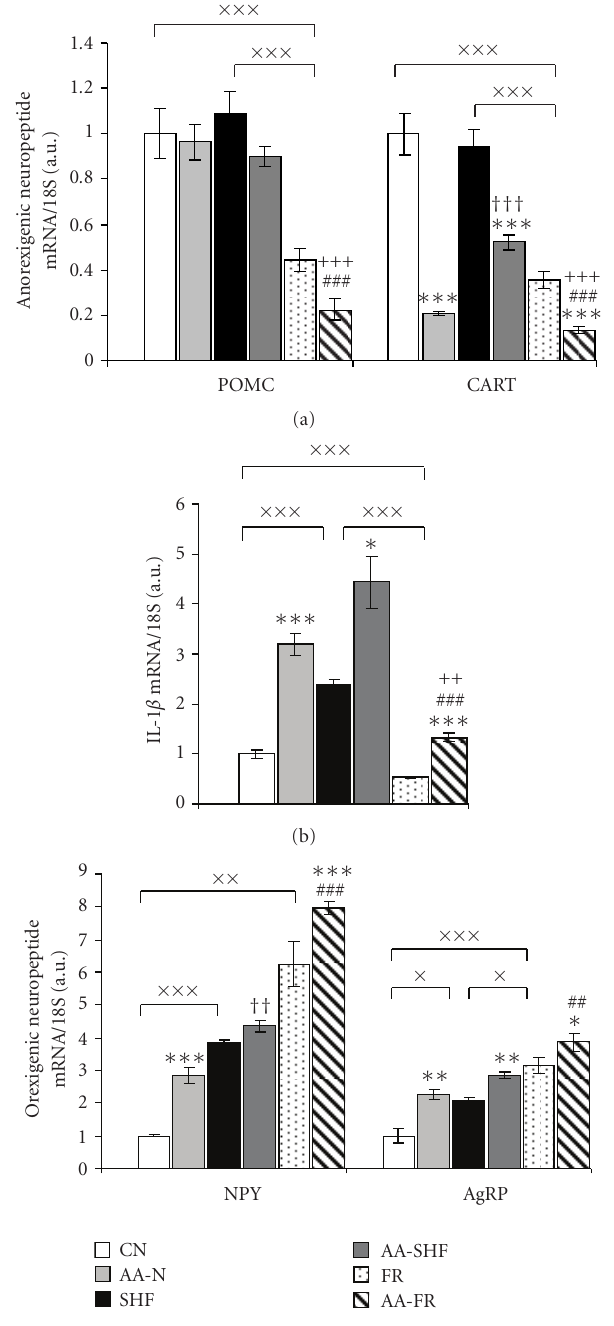
Figure 4: Anorexigenic (a) and orexigenic (c) neuropeptide and IL- 1 β (b) mRNA expressions in the ARC in healthy control (CN, SHF, FR) and arthritic rats (AA-N, AA-SHF, AA-FR) on day 18 after cFA inoculation. Results are expressed in arbitrary units as the ratio of given mRNA to 18S rRNA. Significant di ff erences between healthy controls on di ff erent dietary regime: × P < . 05, ×× P < . 01, ××× P < . 001. Significant di ff erences between control rats and arthritic rats on the same dietary regime: ∗ P < . 05, ∗∗ P < . 01, ∗∗∗ P < . 001. Significant di ff erences between arthritic groups: ## P < . 01, ### P < . 001 (AA-FR versus AA-N); ++ P < . 01, +++ P < . 001 (AA-FR versus AA-SHF); †† P < . 01, ††† P < . 001 (AA-SHF versus AA-N). For abbreviations see Figure